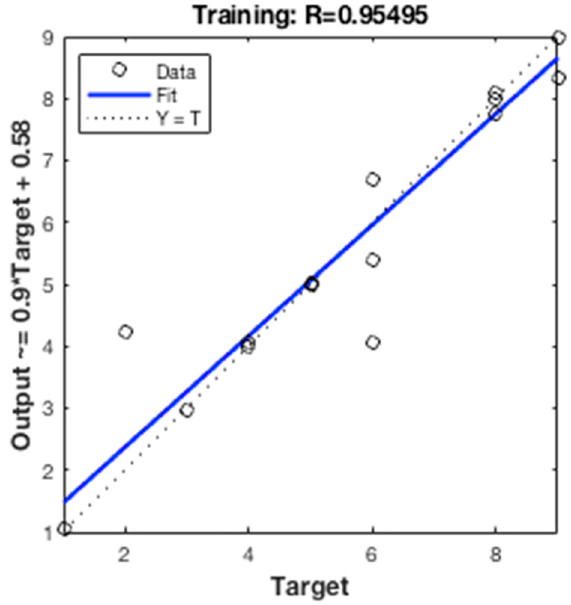
Figure 7. Regression outcomes in the training phase of the proposed MLANN.